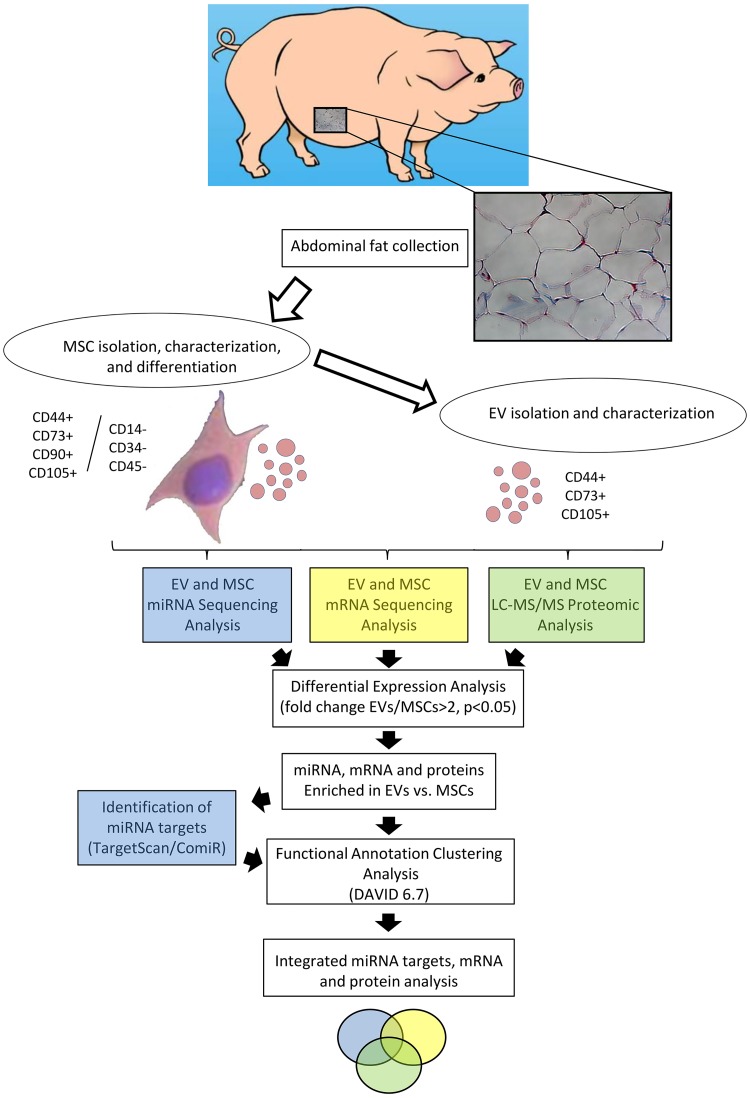
Overview of experimental design and data analysis.Abdominal fat was collected from female domestic pigs, and mesenchymal stem cells (MSCs) and their daughter extracellular vesicles (EVs) isolated and characterized. mRNA and miRNA sequencing analysis and LC-MS/MS proteomic analysis were performed in both MSCs and EVs (n = 3 each). Differentially expression analysis was performed and EV-enriched miRNA, mRNA, and proteins identified. miRNA predicted targets were identified with TargetScan and ComiR. Functional annotation clustering analysis was performed using DAVID 6.7 database to obtain a ranking of primary gene ontology categories for the enriched mRNA, miRNA target genes, and proteins. Venn diagrams were used to visualize genes shared between each group and their interactions, and STRING to predict associations between mRNA and miRNA target genes.